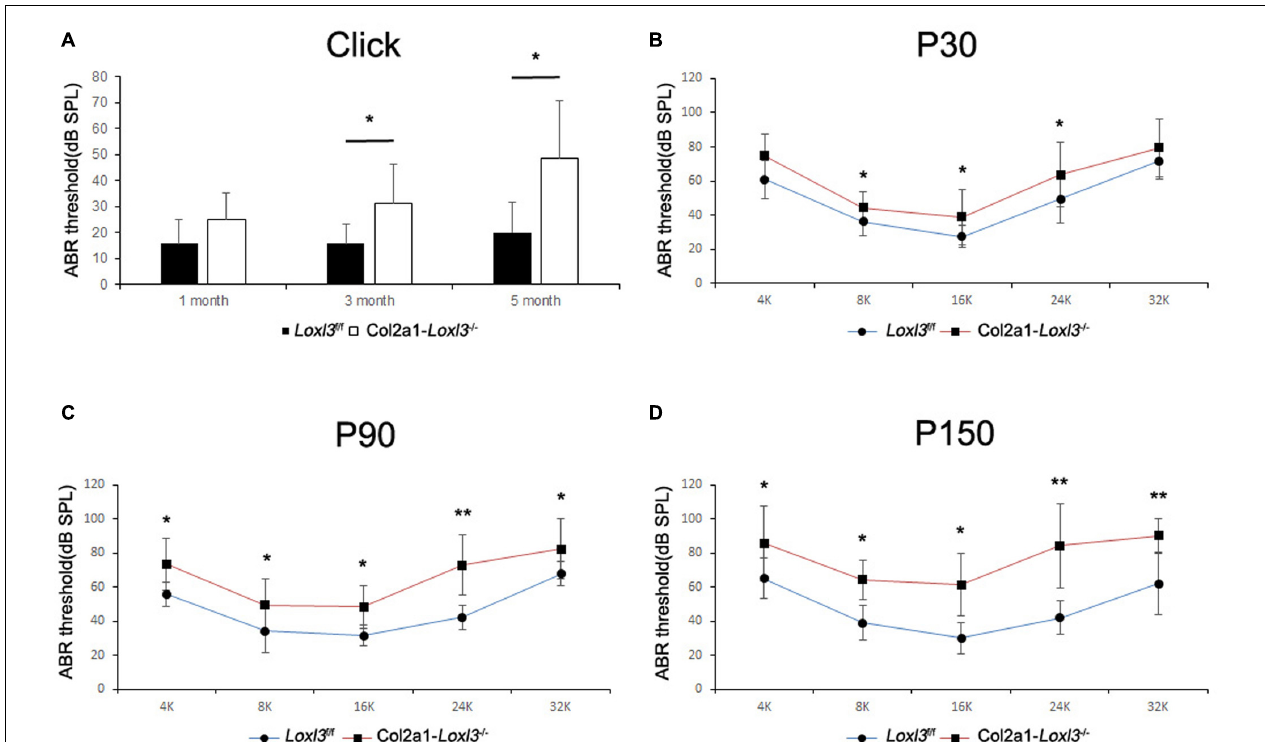
FIGURE 2 | ABR analysis between Loxl3 f / f and Col2a1–Loxl3 − / − mice. (A) ABR thresholds with a broadband click between Loxl3 f / f and Col2a1–Loxl3 − / − mice ( n = 10). No obvious difference was observed at P30, and the ABR thresholds were increased significantly at P90 and P150, indicating progressive hearing loss. (B–D) ABR thresholds with frequency-specific pure tone stimuli (containing 4, 8, 16, 24, and 32 k) ( n = 10). The ABR thresholds were increased significantly from P30 to P150. * p < 0.05; ** p < 0.01 by two-tailed Student’s t